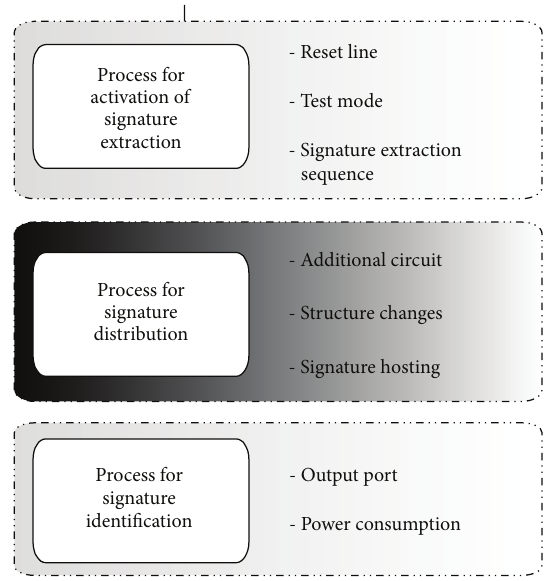
Figure 1: Processes involved in HDL